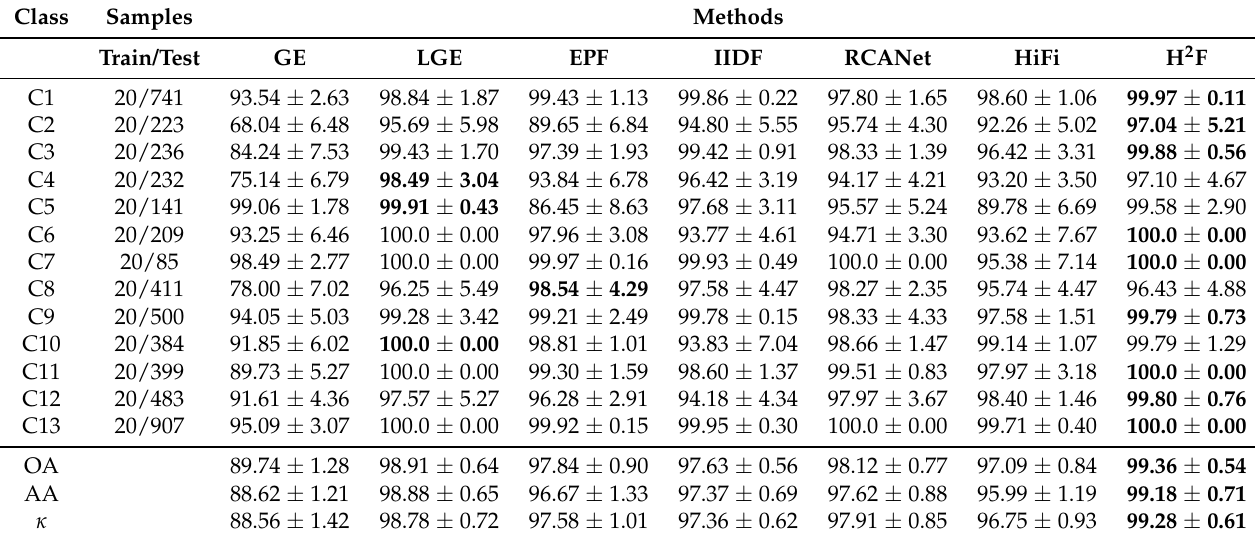
Table 2. Classification accuracies of different methods on the KSC data set